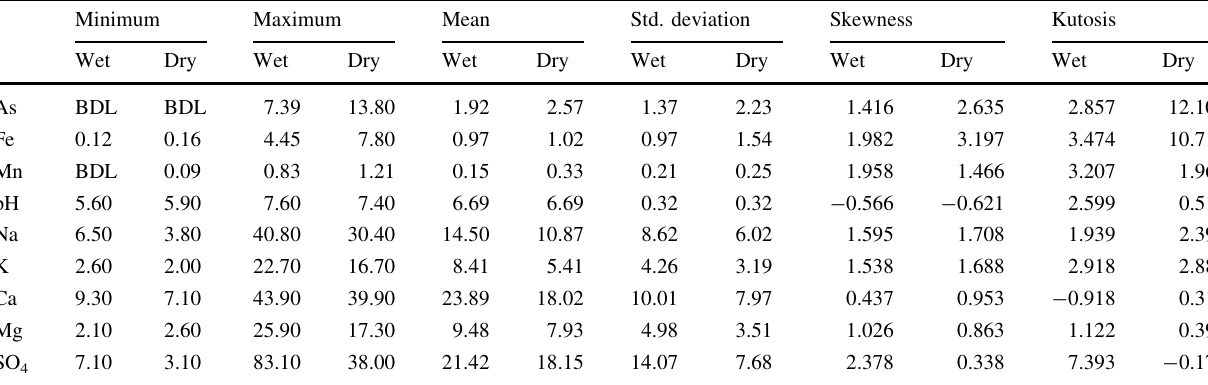
Table 1 Descriptive statistics of water quality parameters in the shallow aquifers Minimum Maximum Mean Std. deviation Skewness